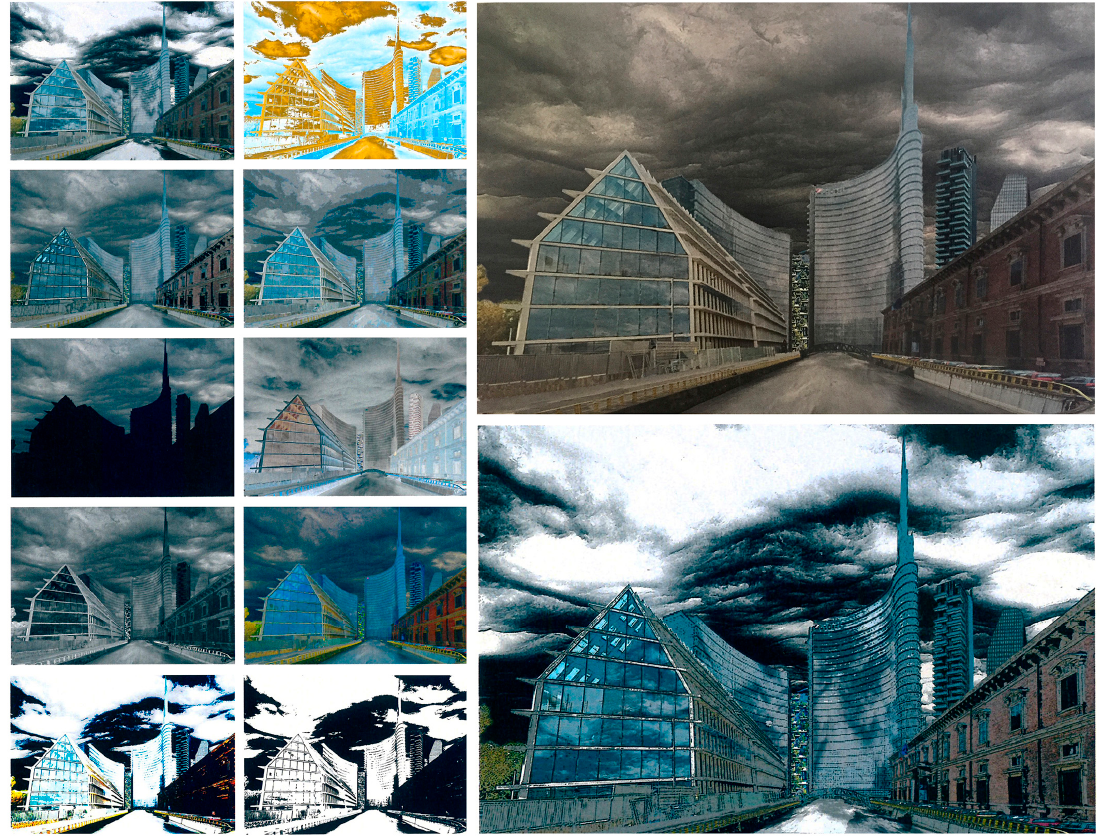
Figure 1. A collage realized by a student of the course. The image puts together physically distant buildings into a real scenario, then the image is treated with software to lose